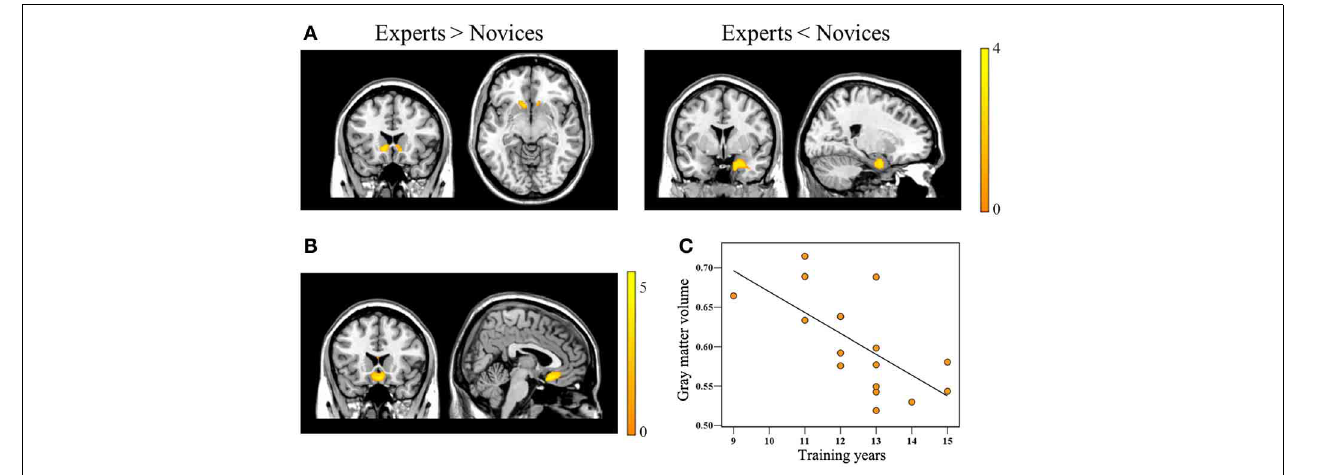
FIGURE 1 | Brain regions showing significant group differences in gray matter volume and showing a correlation with Baduk training years. Relative to novices, Baduk experts showed significantly increased gray matter volume in the bilateral caudate, particularly the nucleus accumbens,